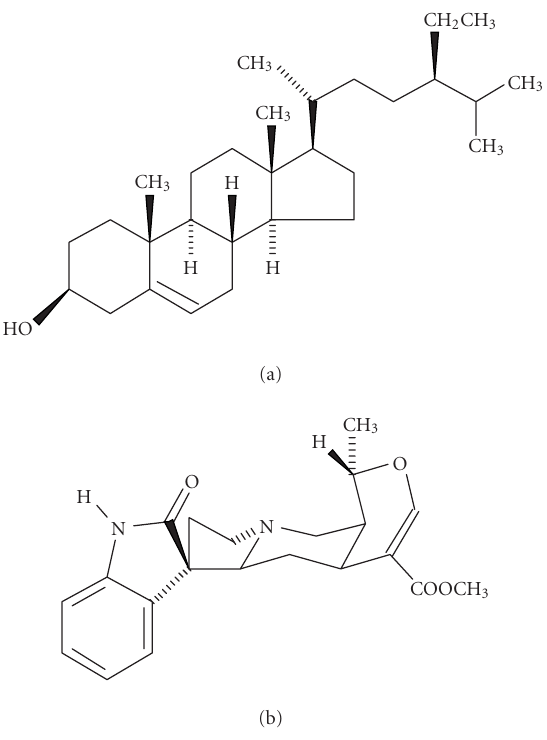
Figure 1. Stereochemical structure of beta-sitosterol (a) and pteropodine